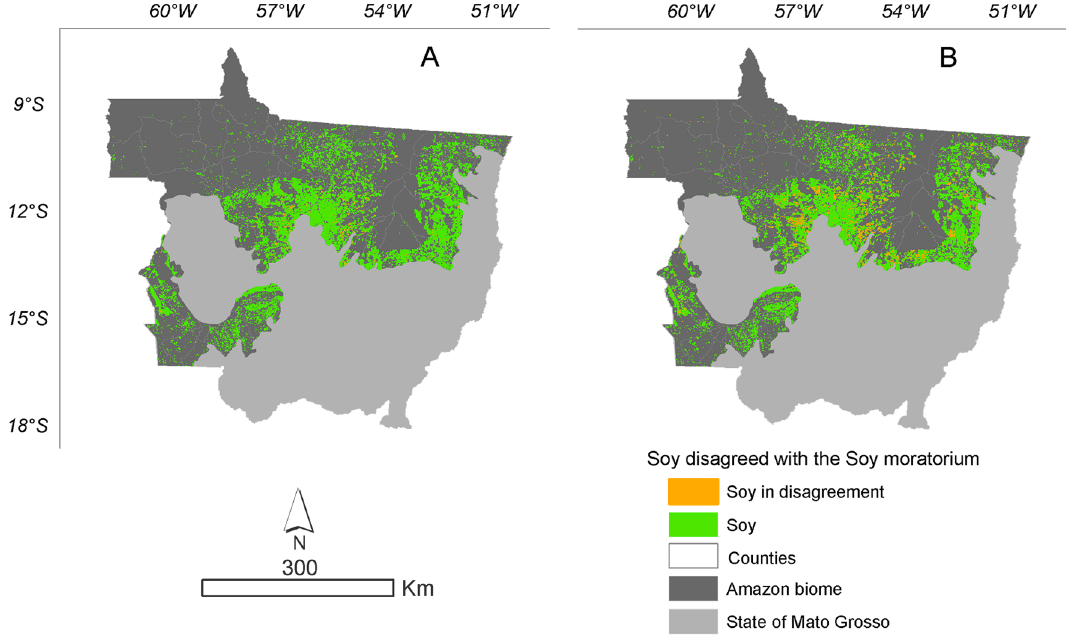
Figure 7. Accumulation of soybean planted in deforested area. ( A ) Soybean planted in deforested area according to ImazonGeo deforestation data. ( B ) Soybean planted in deforested area according to PRODES deforestation